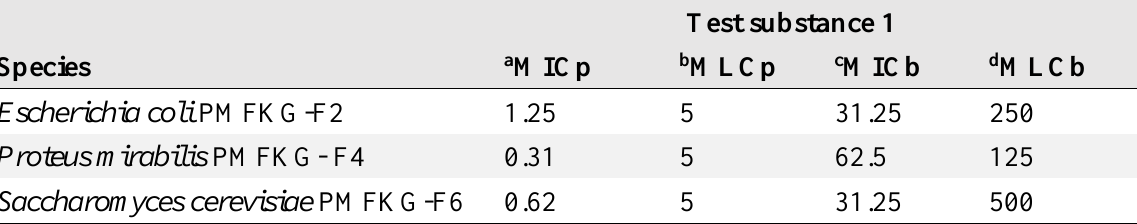
Table 4. Resistance of planktonic cells and biofilms on the presence of test substance